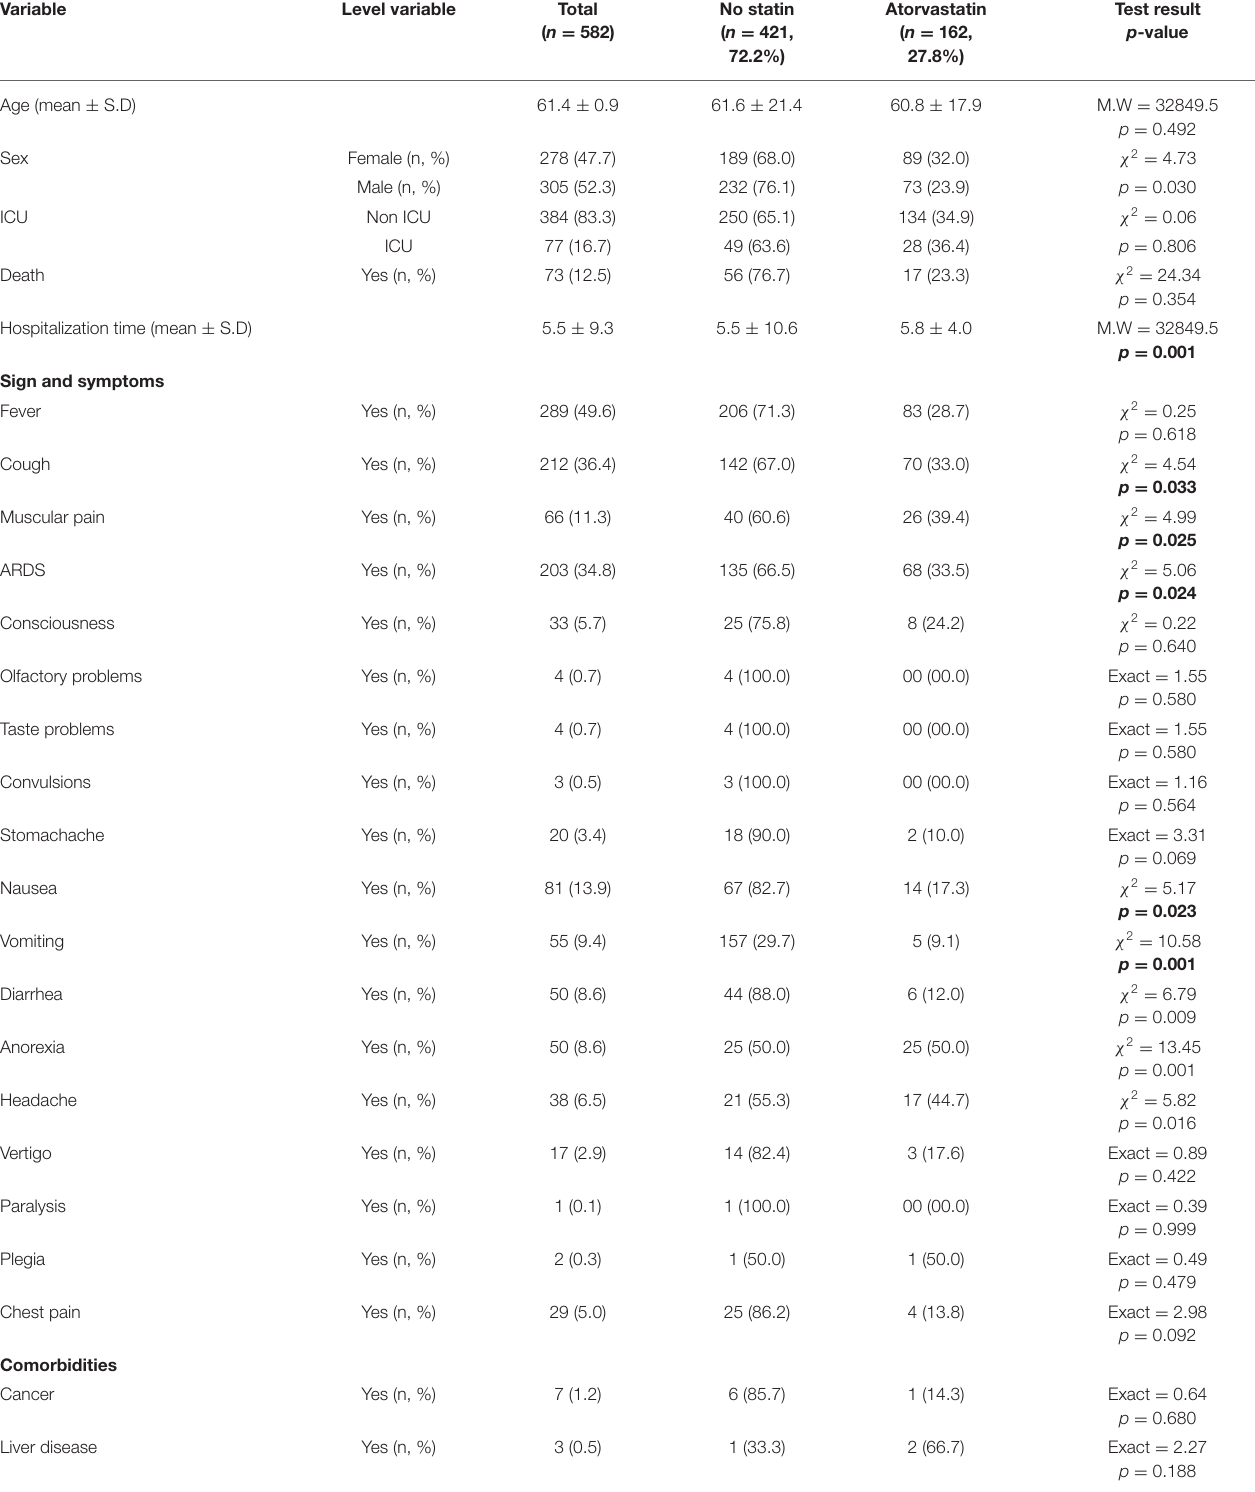
TABLE 1 | Characteristics of patients in statin and non-statin groups.